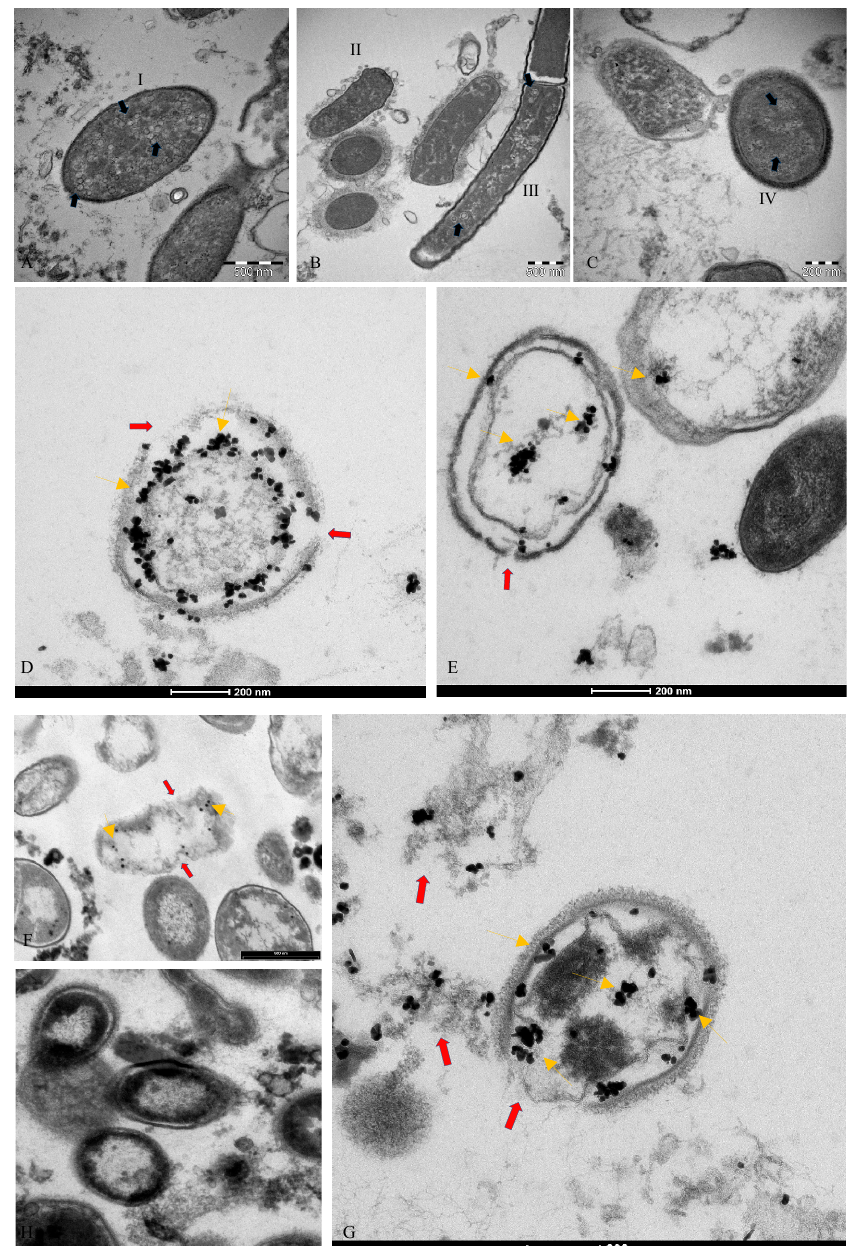
Vaccines 2022 , 10 , 708 7 of 13 samples B1 (green line), B2 (yellow line), and B3 (azure line) infected each one with three different A donor sources. To normalize the measurements, all values at day 0 were normalized as described in panel ( A ). Panels C-L show the immunofluorescence microscope images (magnification 100X, Zeiss Axioplan 2, Axiocam 305 color, Carl Zeiss Microscopy GmbH, Carl-Zeiss-Promenade 10, 07745 Jena, Germany) on bacterial cultures (performed at 30 days) from the patients positive to SARS- CoV-2 with anti-Gram-positive bacteria (green signal, ( C )) and anti-SARS-CoV-2 nucleocapsid pro- tein (red signal, ( D )) antibodies. ( E ): merge of C and D images, particles positive to both antibodies were indicated by white arrows. ( F – I ): computerized magnification of particles numbered in ( C – E ). Panel ( L ): negative control by omitting primary antibodies. Panel ( M ) is the merge of the negative control of a healthy fecal bacterial culture, in which the anti-bodies versus nucleocapsid protein did not give signal and Gram+ bacteria are present. See text for more details.